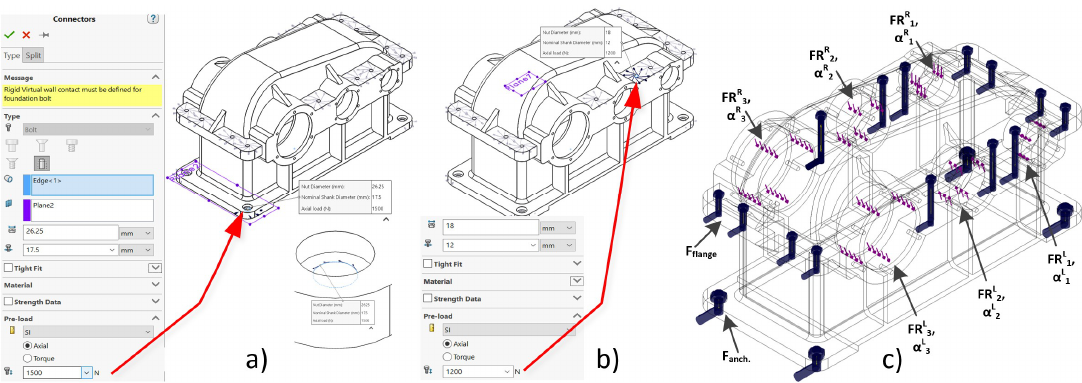
Figure 5. Defining the axial loads for anchor ( a ) and flange ( b ) bolt-nut connections in SOLIDWORKS Simulation; ( c ) Diagram of the reducer body and cover housing 3D model with all load applied.